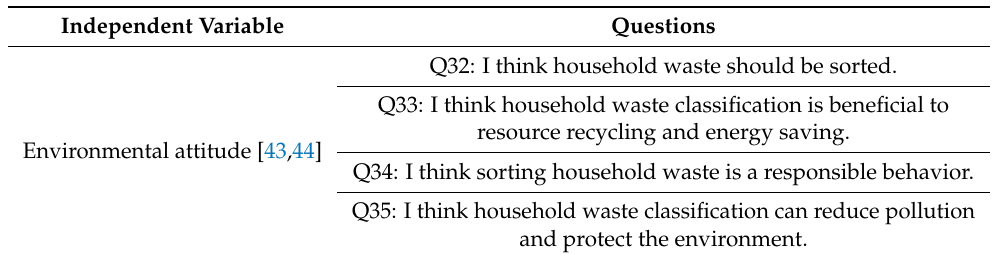
Table 8. Environmental attitude